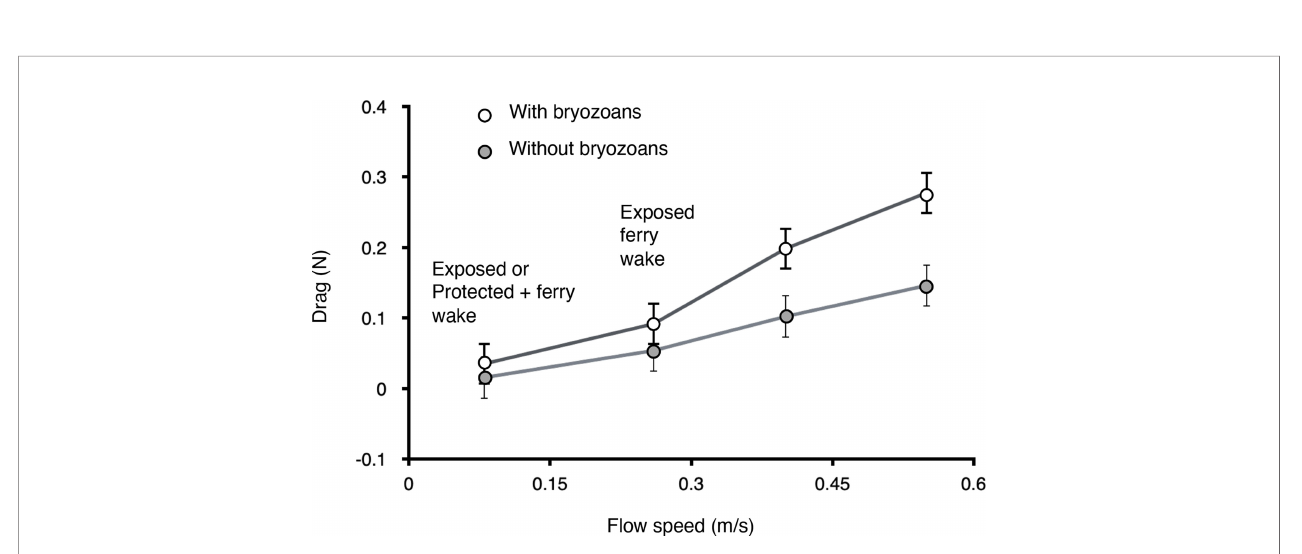
FIGURE 7 | Drag in unidirectional fl ow on M. splendens fouled by M. membranacea (white circles; mean cover of bryozoans = 12%, SD = 5.0, n = 5) and on the same algae after the bryozoans were removed (grey circles), measured at a range of fl ow velocities in a fl ume. The 0.8 m s -2 fl ow represents the peak velocities measured in wind chop at the exposed site, and also the peak velocities measured in ferry wakes at the protected site. The 0.26 m s -2 fl ow represents the peak velocities measured in ferry wakes at the exposed site. Error bars represent one standard